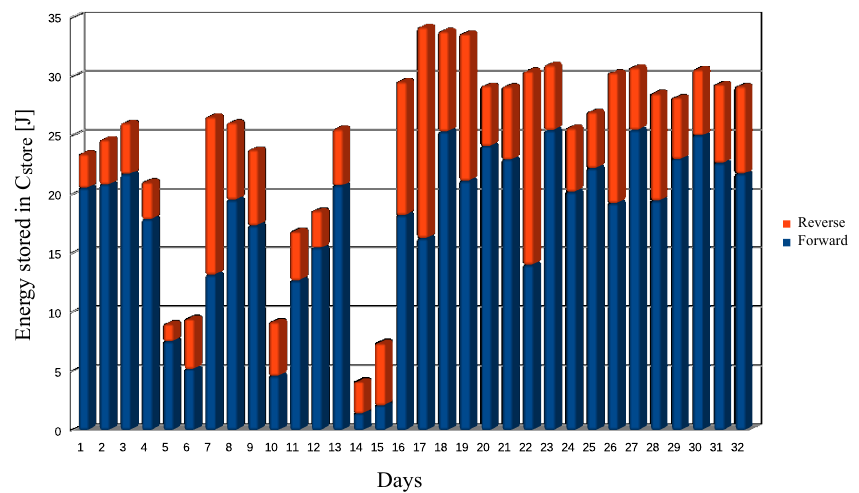
Figure 14. Values of the stored energy in the supercapacitor, measured during 32 days (July 5 to 5 August 2015), in Campinas. The blue bars are the “forward” energy and the red bars are the “reverse”